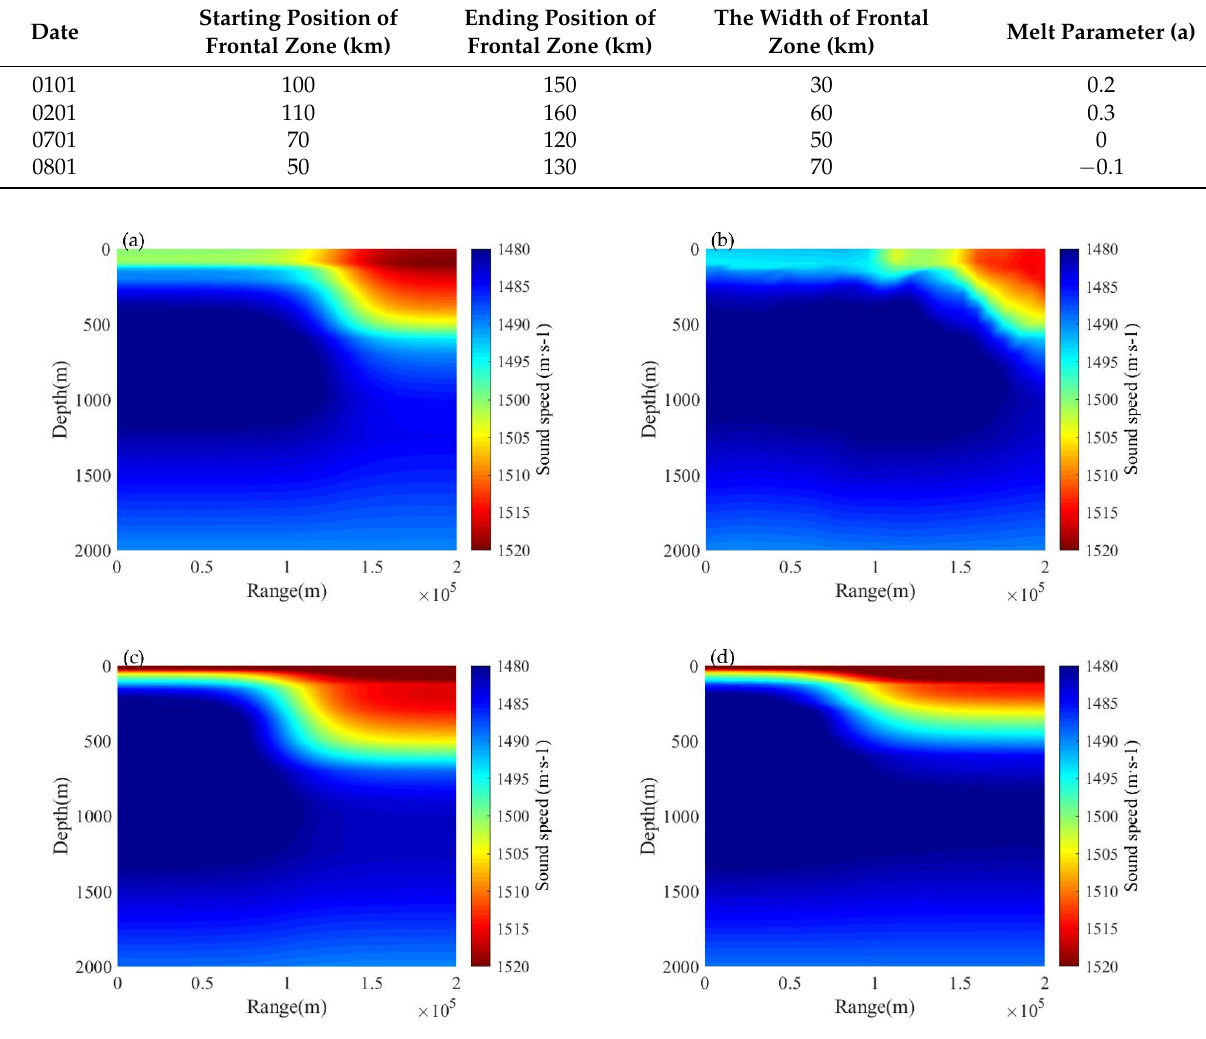
Figure 8. The model of the sound speed field of the KEF (0 – 2000 m): ( a ) 1 January 2019; ( b ) 1 February 2019; ( c ) 1 July 2019; ( d ) 1 August 2019. The distribution of sound speed obtained by the overall model was similar to that of the actual KEF (Figure 2) in terms of the location of the front and the depth of the influence (especially in winter). Because only two typical water mass sound speed profiles and the location information of frontal zone was extracted as input in our model, the results of the model are still different from the actual distribution of the sound speed of the ocean front in detail.